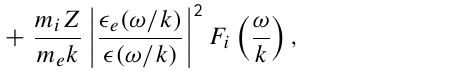
Fig. 8. Left: The EDF for n ≡ 20% and V p =40km/s over all 256 positions. Right: The EDF over the first 64 positions; the lines in black are